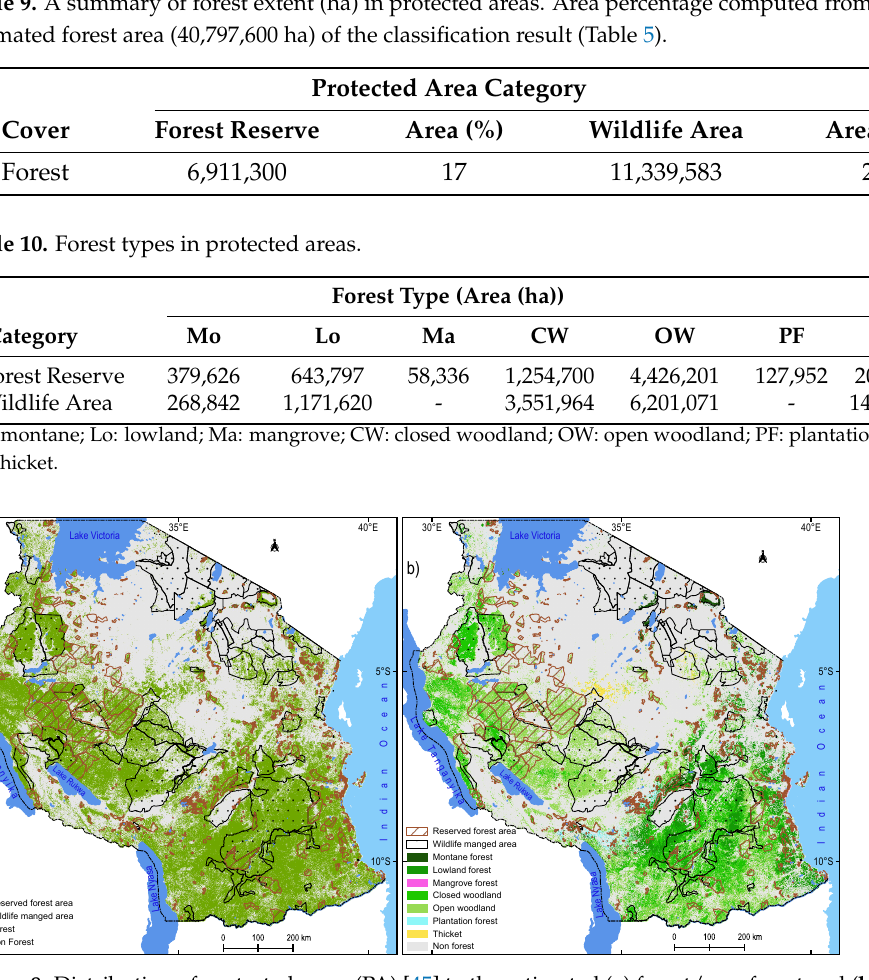
Figure 8. Distribution of protected areas (PA) [45] to the estimated ( a ) forest/non-forest and ( b ) forest types in Tanzania.